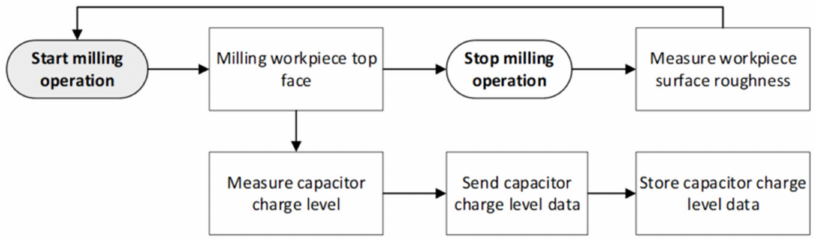
Figure 17. The flow chart of process steps used during experiment